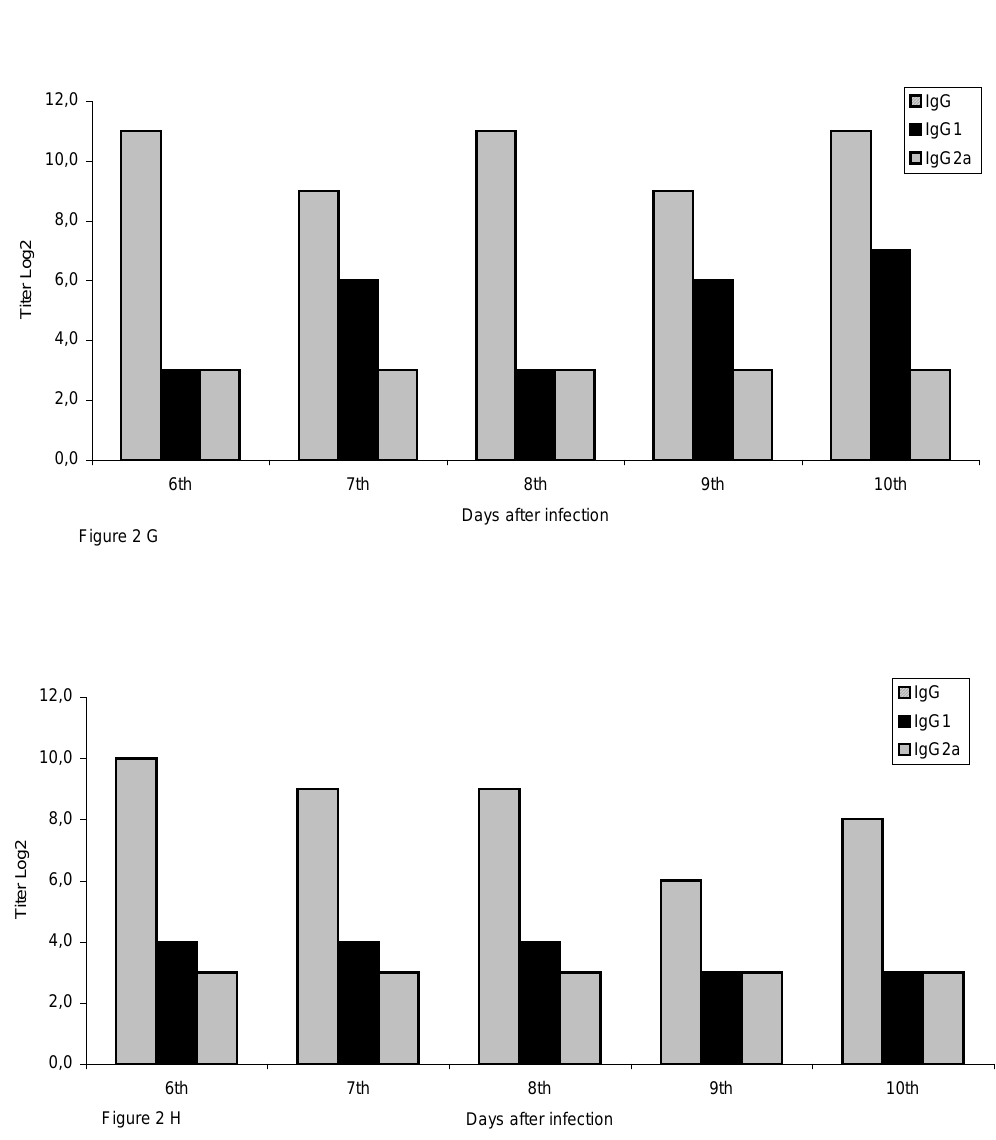
Figure 2: Kinetics of IgG, and IgG maximal and minimal acute inflammatory reaction (AIRmax and AIRmin) during infection by the rabies virus. Animals received intracerebral injections with 100 LD of PV1 43/4 and AgV3 strains. Sera were collected at different times from animals showing rabies symptoms and IgG, IgG the ELISA